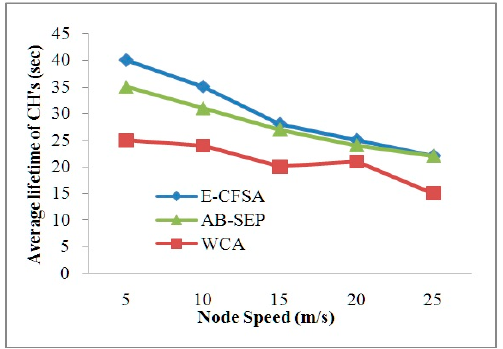
Figure 16. Graph Average Stability Time Vs. Node speed.